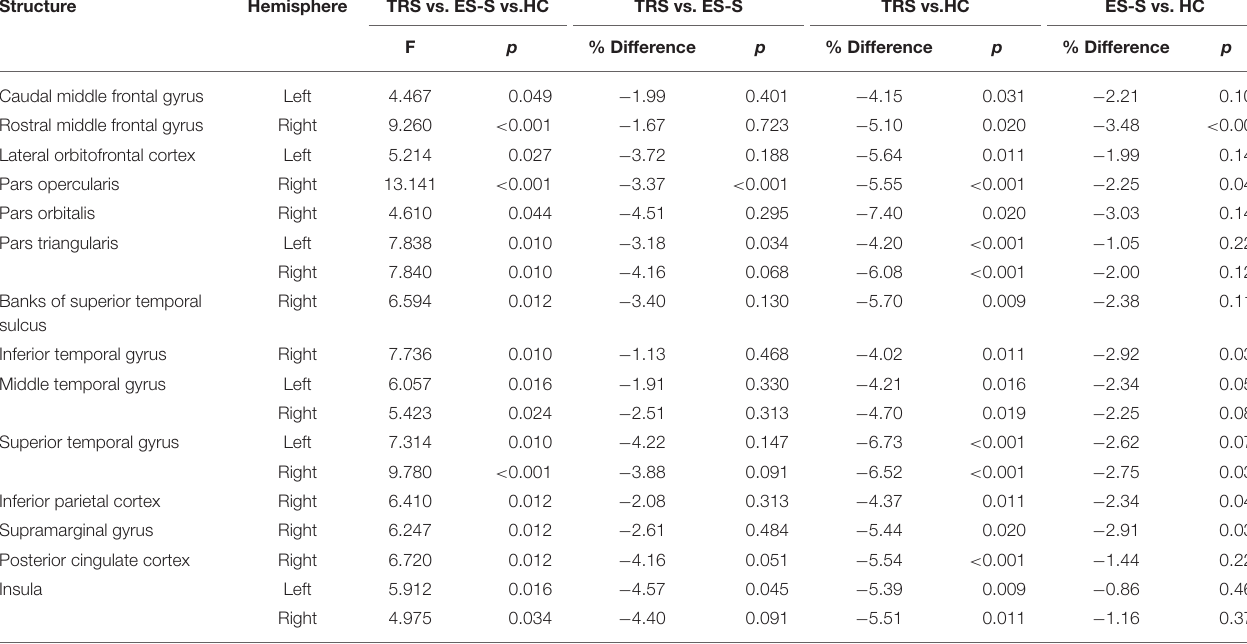
TABLE 2 | Comparison of cortical thickness among patients with TRS ( n = 46) and ES-S ( n = 45), and HC ( n = 61). Structure Hemisphere TRS vs. ES-S vs.HC TRS vs. ES-S TRS